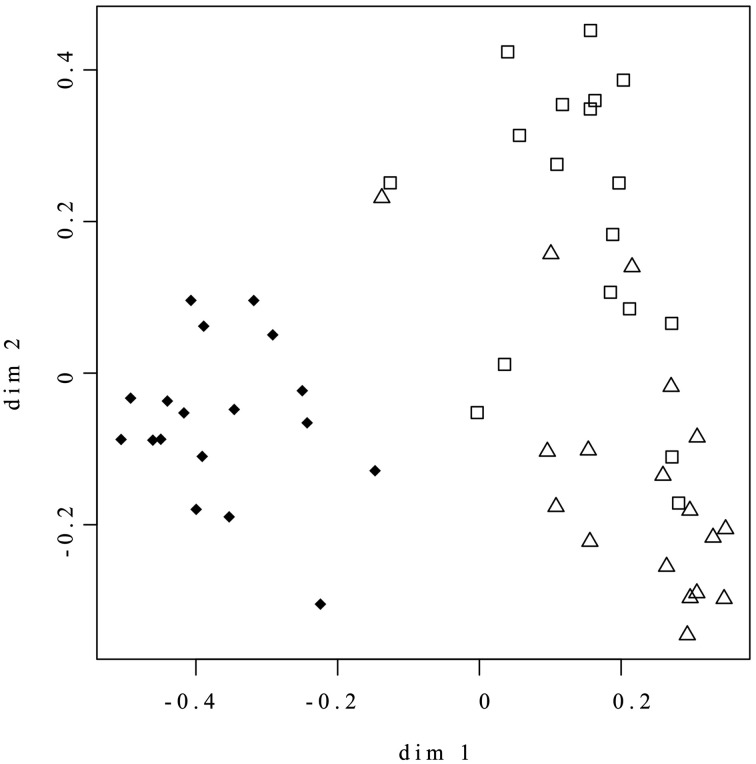
Random Forest Unsupervised analysis of whole set of NMR data. ♦ = Nox; Δ = 0.4ox; □ = 0.8ox. The axes represent the coordinates of the points in the Euclidean space reconstructed from the Random Forest proximity matrix, as detailed in the Materials and Methods Section. Similar samples, i.e., samples with similar metabolic content, tend to be tightly clustered.